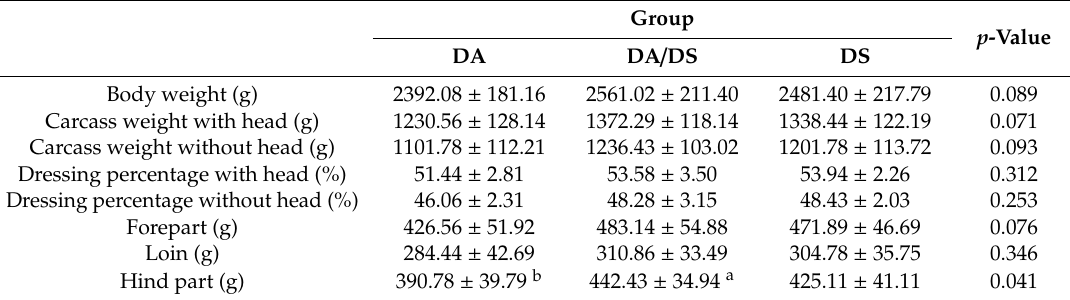
Table 6. Carcass characteristics of rabbits (mean ± SD; n = 30).